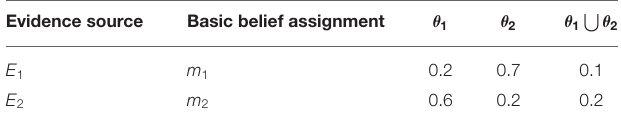
TABLE 2 | Basic trust distribution table.